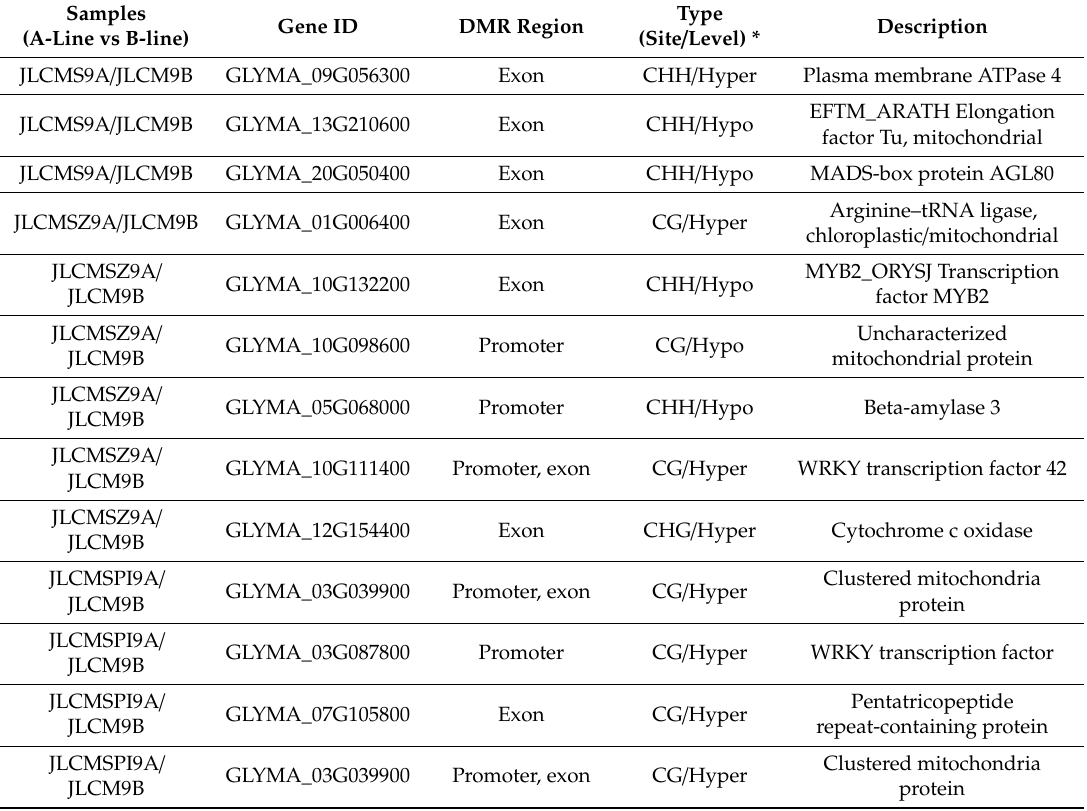
Table 3. Di ff erentially methylated region (DMR)-related genes potentially involved in cytoplasmic male sterility and gene function among soybean A lines and B